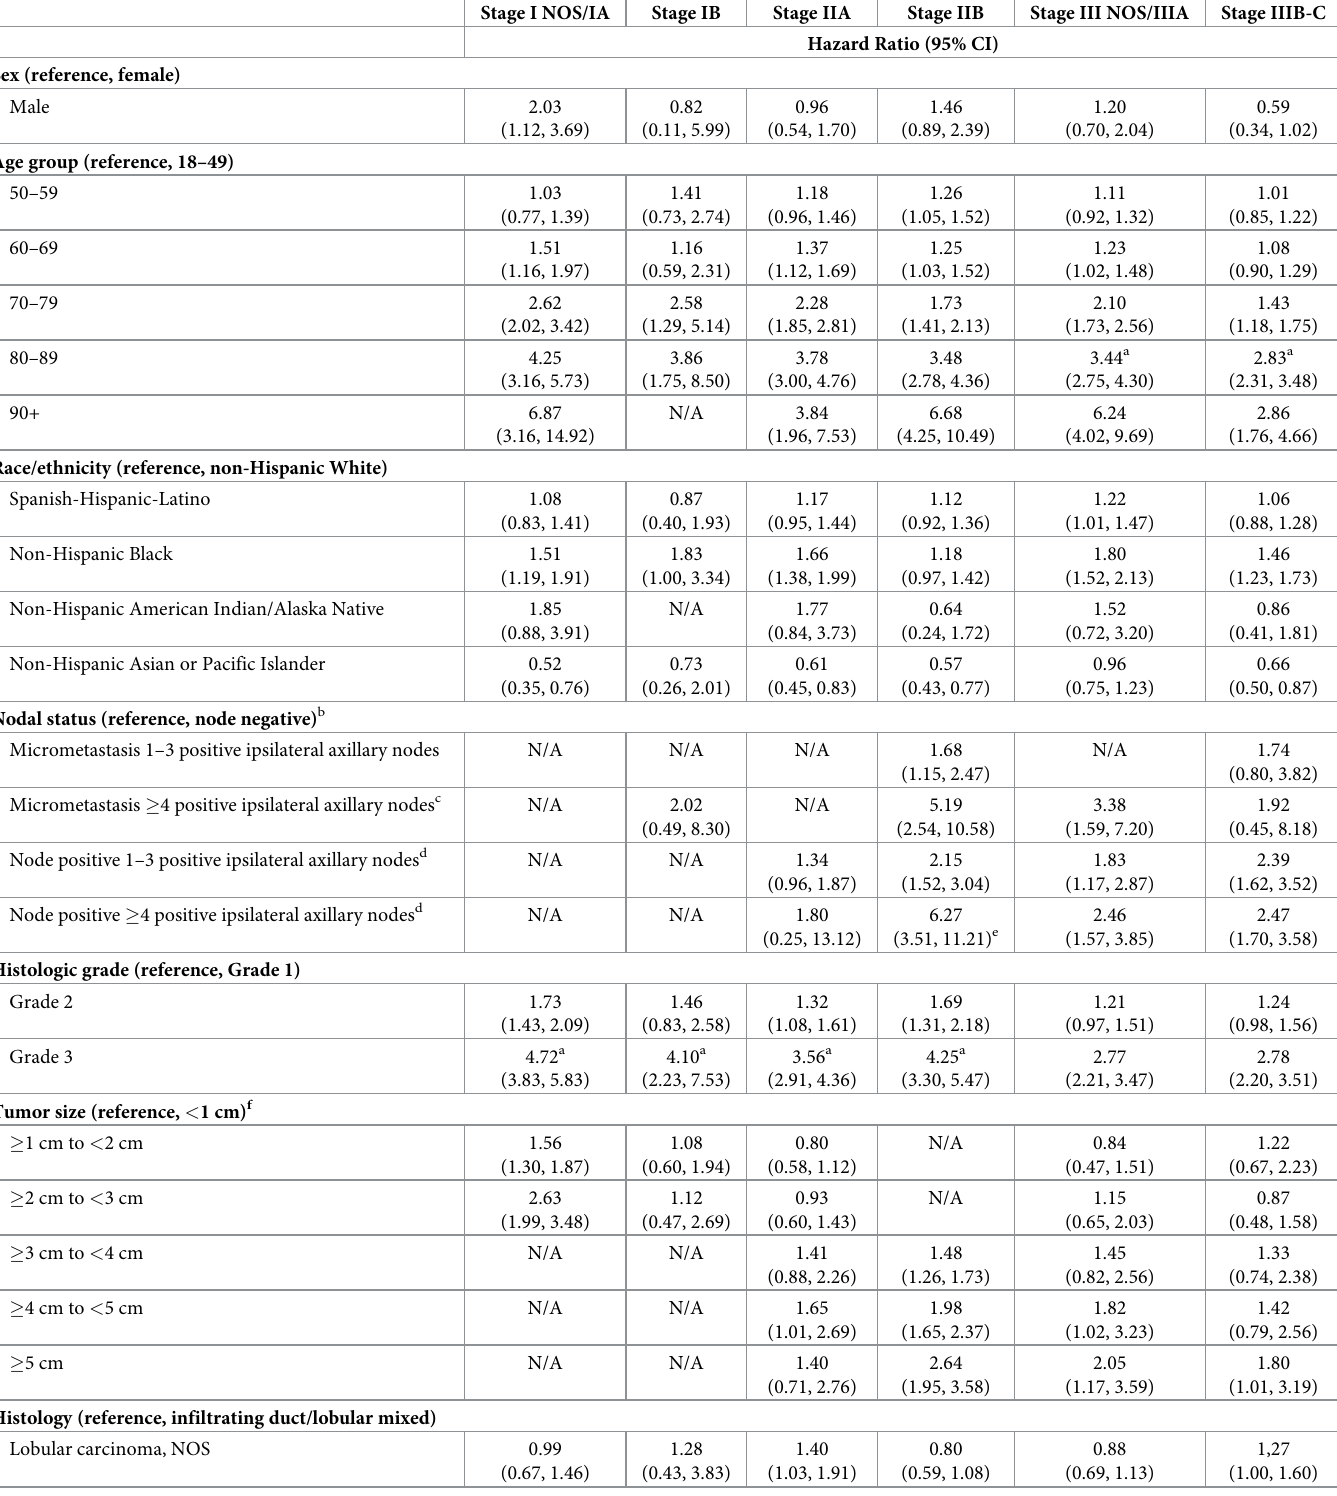
Table 2. Hazard ratios (95% confidence intervals) for breast cancer-specific mortality within HR+, HER2- subtype, by